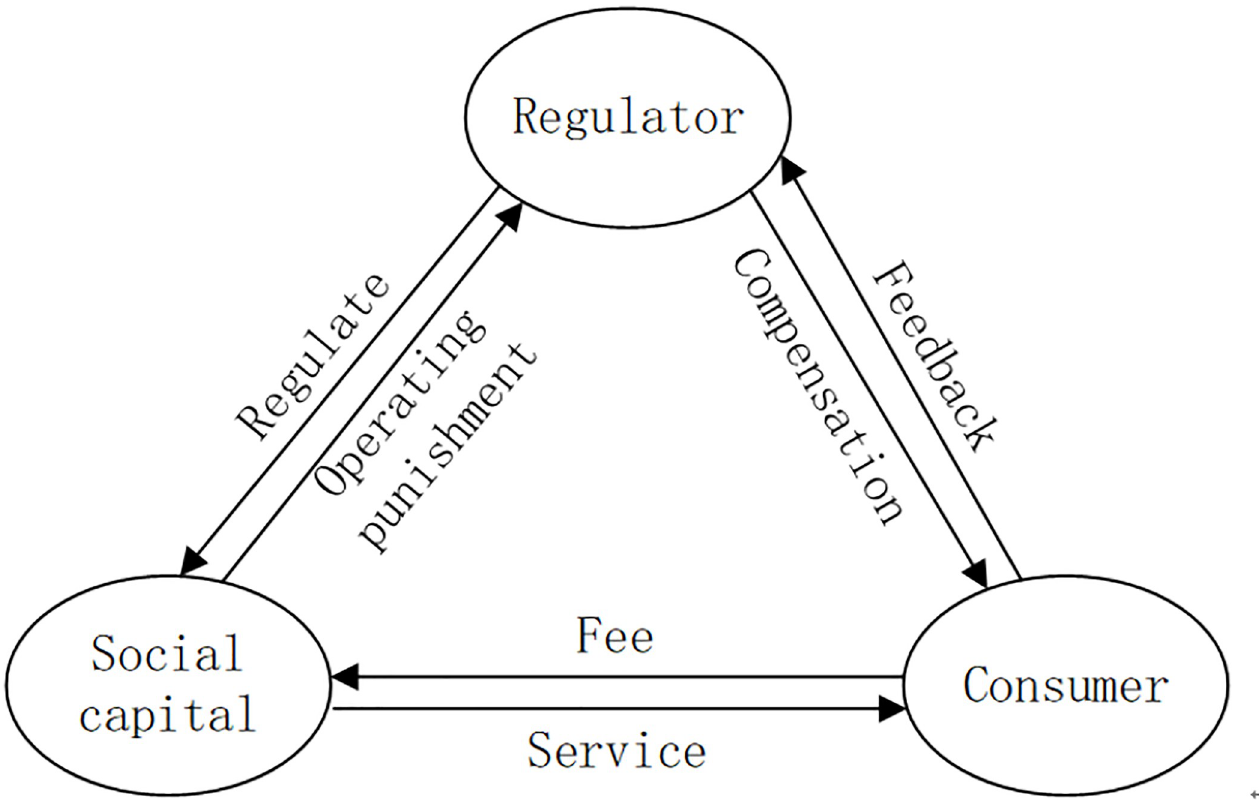
Fig 1. The relationships among regulator, social capital,